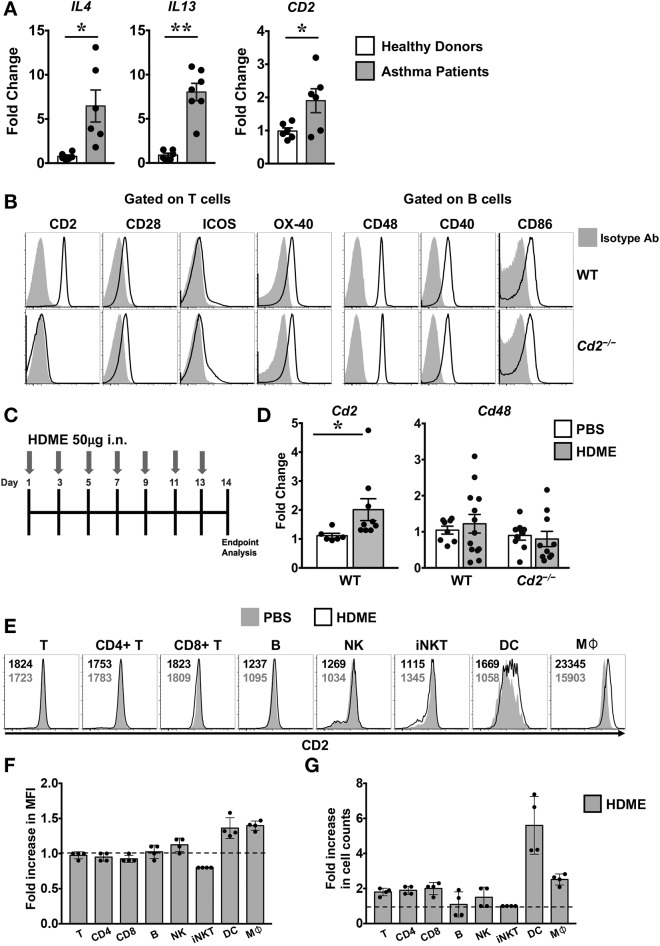
Increased expression of CD2 in the lungs of human asthmatics and HDME-challeged mice. (A) Whole lung tissue from healthy donors and asthma patients were analyzed for gene expression of IL-4, IL-13 and CD2. Data is shown as mean fold change ± SEM with a total of 6–7 samples per cohort. (B) Surface expression of various co-stimulatory molecules (CD2, CD28, ICOS, and OX-40) gated on T cells and ligands for costimulatory molecules (CD48, CD40, and CD86) expressed on B in the lungs of naïve Balb/c (WT) and Balb/c. Cd2−/− (Cd2−/−) mice. Data are representative of at least 4 mice per genotype. (C) Schematics of the asthma model used in the study. Mice were challenged intranasally (i.n.) with HDME on alternate days for a total of 7 injections. (D) Lung tissues of WT and Cd2−/− mice injected with PBS or HMDE were analyzed for Cd2 (left) and Cd48 (right), as indicated in the figure. Data is presented as mean fold change ± SEM and is pooled from 3 independent experiments with a total of 8–13 mice per cohort. Statistical significance in (A,E) was determined by using Student's unpaired t-test with Welch's correction. *p ≤ 0.05, **p ≤ 0.01. (E–G) Mice were challenged intranasally (i.n.) with HDME for a total of 3 injections. Two hours after the last injection, mice were sacrificed and lung tissues were analyzed for surface expression of CD2 by flow cytometry. Representative histograms depict CD2 expression on various immune cells (as indicated in the figure, E). Numbers in the histograms indicate mean fluorescence intensity (MFI) of CD2 in HDME-treated (black font, top) and PBS-injected (gray font, bottom) mice. Fold increase in the MFI of CD2 (F) and cell counts (G) of each immune cell type in the lungs of HDME-treated mice as compared to PBS controls are shown. Dotted lines in (E,F) represent the baseline set at 1 for the control group. Data is presented as mean fold change ± SEM and is pooled from 4 mice per cohort.